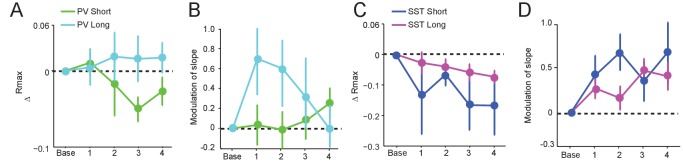
Data for ChR2 stimulation reported in Figure 5 were divided into short (<300 s) and long (>300 s) groups according to preictal latency (See Figure 1—figure supplement 2).(A) Mean change in Rmax compared to baseline over four preictal periods for PVSHORT (n = 10) and PVLONG (n = 7). (B) Mean modulation of the slope parameter compared to baseline over four preictal periods for PVSHORT and PVLONG. (C) Mean change in Rmax compared to baseline for SSTSHORT (n = 4) and SSTLONG (n = 17). (D) Mean modulation of slope compared to baseline for SSTSHORT and SSTLONG.